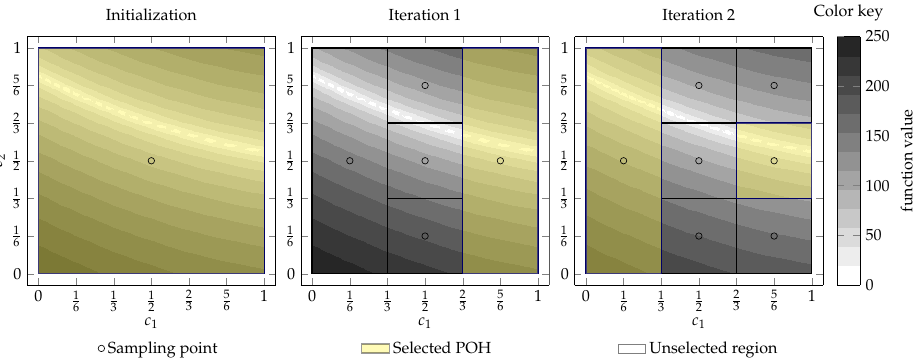
Figure 1. Two-dimensional illustration of trisection used in the original DIRECT algorithm [7], solving Bukin6 test